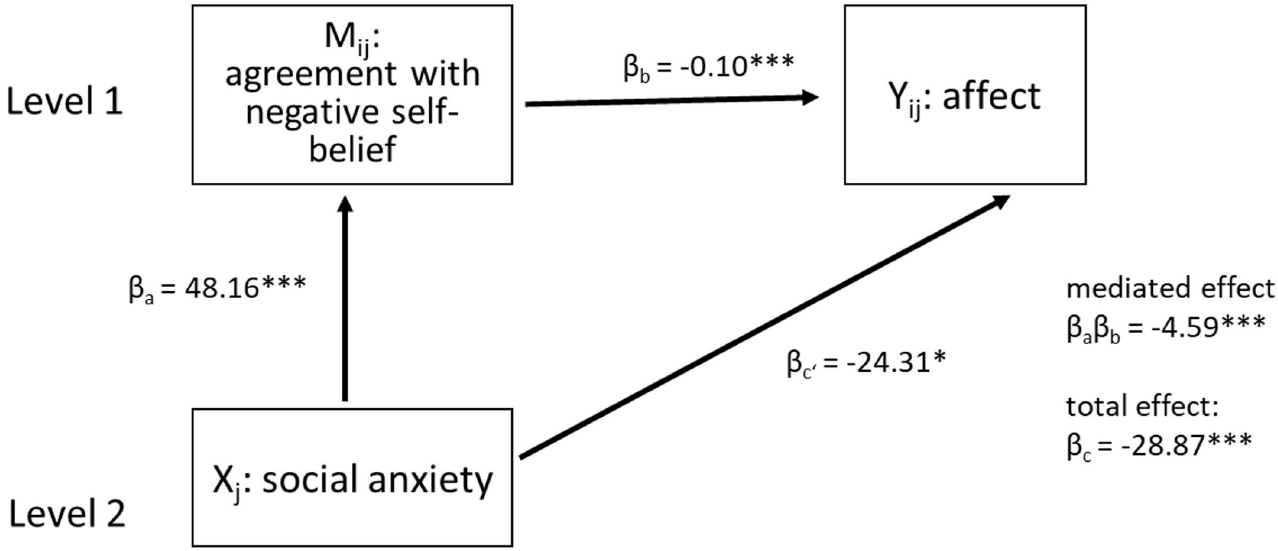
Fig 5. Estimation results of the mediation model for negative self-beliefs.